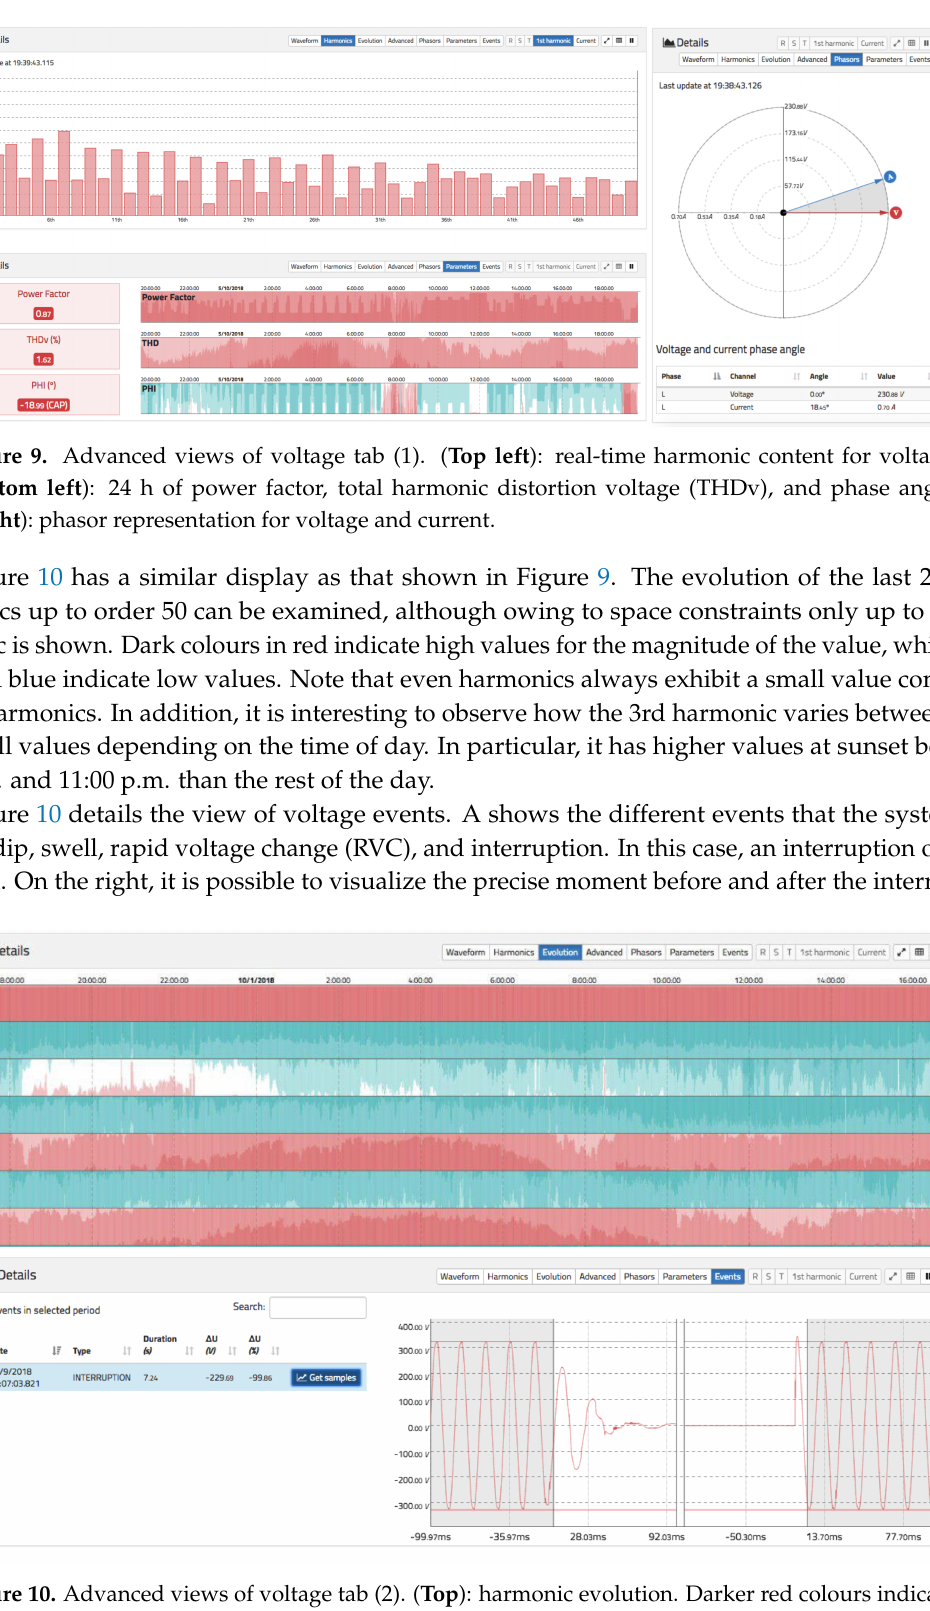
Figure 10. Advanced views of voltage tab (2). ( Top ): harmonic evolution. Darker red colours indicate higher values than darker blue. ( Bottom ): events view with pre- and post-event